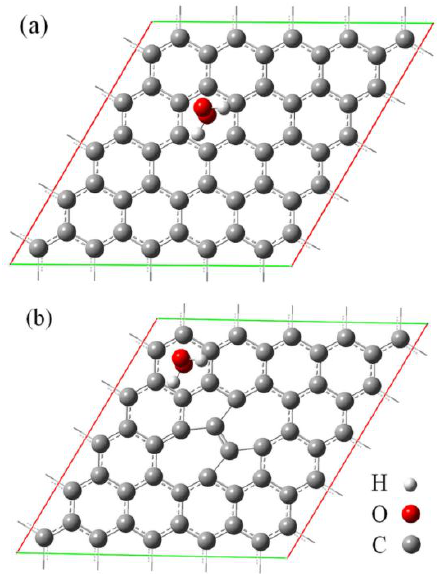
Fig. 2. Most stable adsorption configurations of hydrogen peroxide on (a) defect free and (b) defective